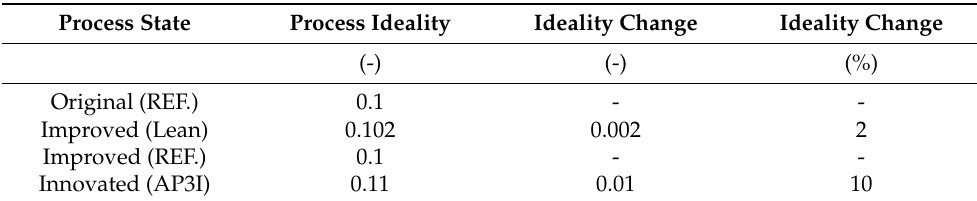
Table 9. Comparison of process ideality—assembly line.